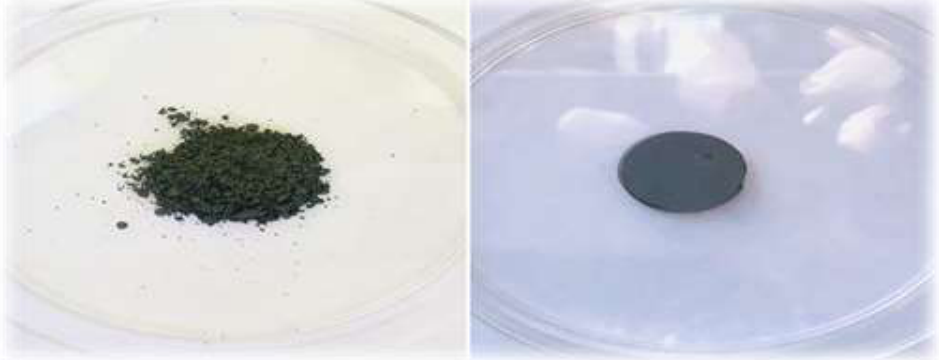
Figure 1: The shape of the aluminum material before and after